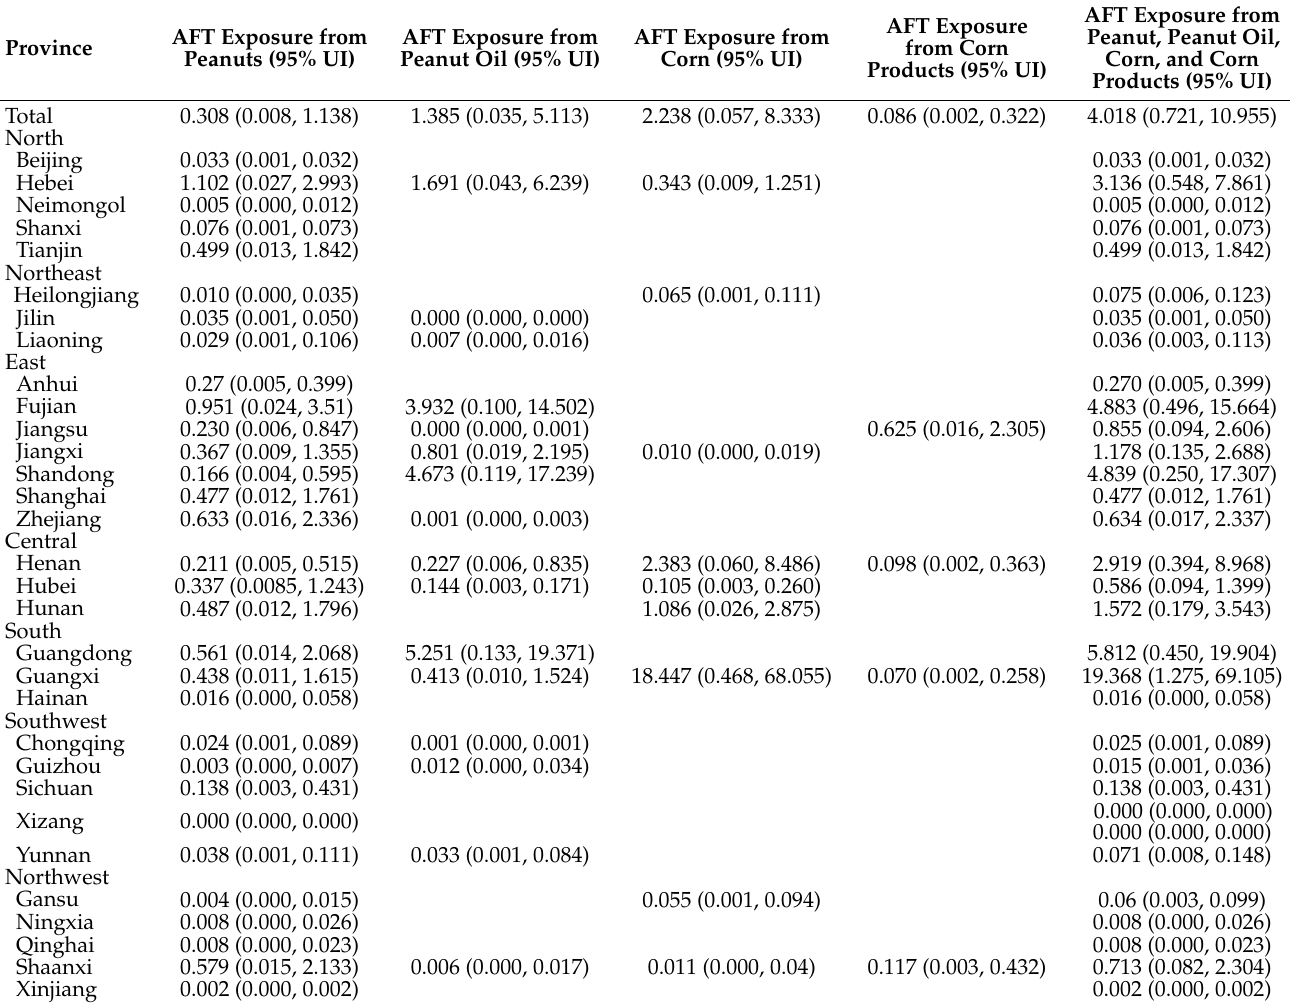
Table 3. AFT intake through peanuts, peanut oil, corn, and corn products in China (ng/kg